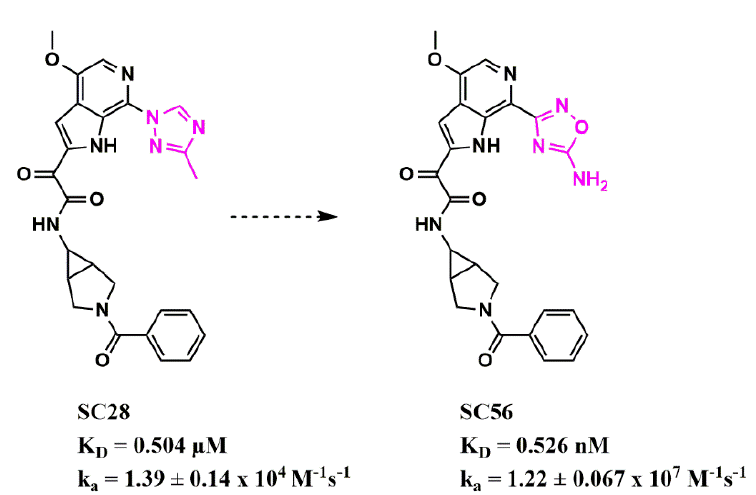
Figure 15. Modulation of binding kinetics using bioisosteric replacement in HIV-1 entry inhibitor design. The structural change between the two compounds is highlighted in pink. Affinity and kinetic parameters were determined using a surface plasmon resonance assay.